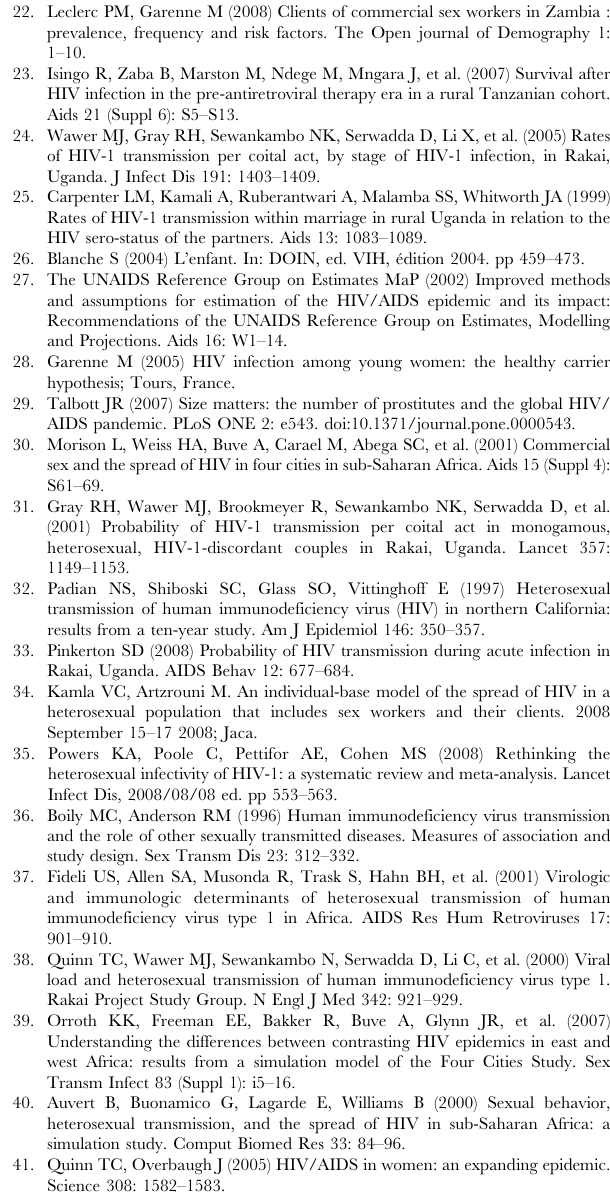
Figure S1 Age pattern of fertility, Zambia. Found at: doi:10.1371/journal.pone.0005439.s003 (0.11 MB TIF) Figure S2 Age pattern of mortality, without HIV/AIDS, Zambia. Found at: doi:10.1371/journal.pone.0005439.s004 (0.12 MB TIF) Figure S3 Proportions ever married, and ever had intercourse, after from fitting with the Picrate model. Found at: doi:10.1371/journal.pone.0005439.s005 (0.14 MB TIF) Figure S4 Bivariate gamma distribution of age of husband and wife, first marriage. Found at: doi:10.1371/journal.pone.0005439.s006 (0.21 MB TIF) Figure S5 Bivariate gamma distribution of age of husband and wife, remarriage. Found at: doi:10.1371/journal.pone.0005439.s007 (0.22 MB TIF)